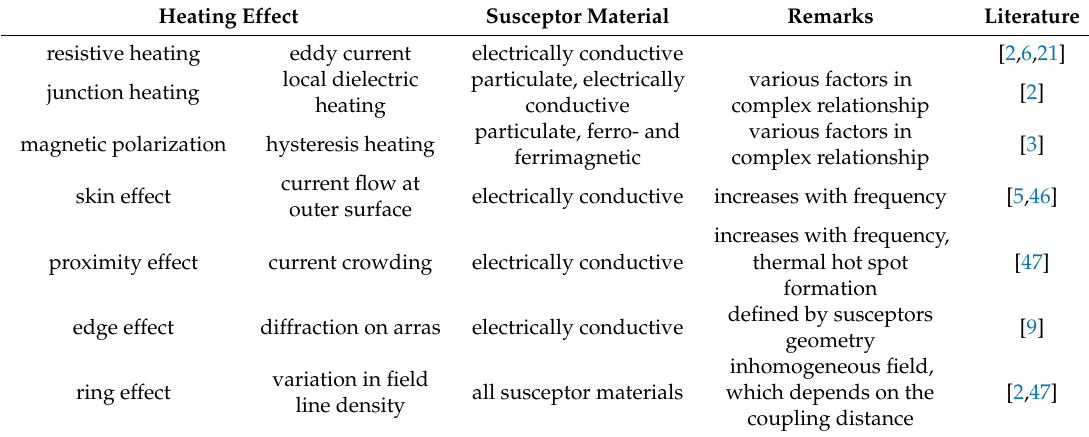
Table 1. Thermal processes in susceptor materials.